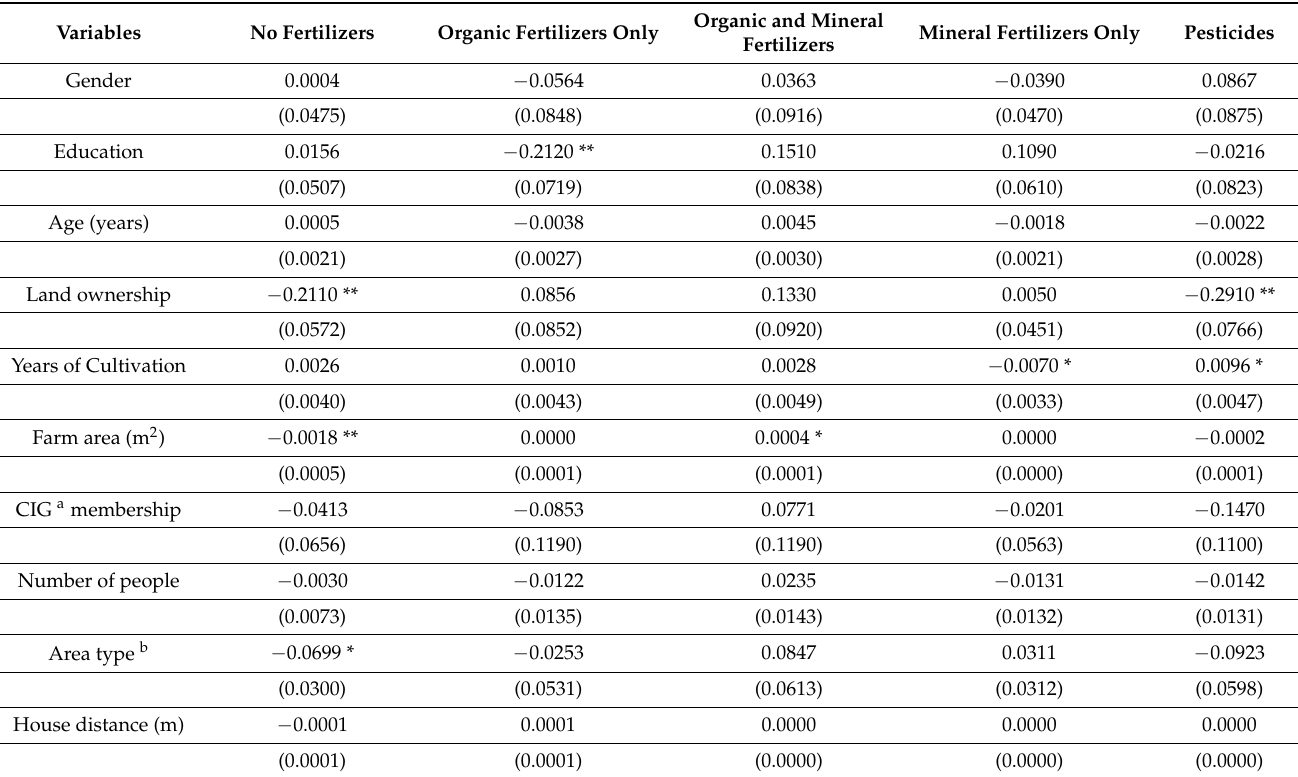
Table 5. Factors influencing the use of various agrochemicals (fertilizers and pesticides) in smallholder farms in Yaound é